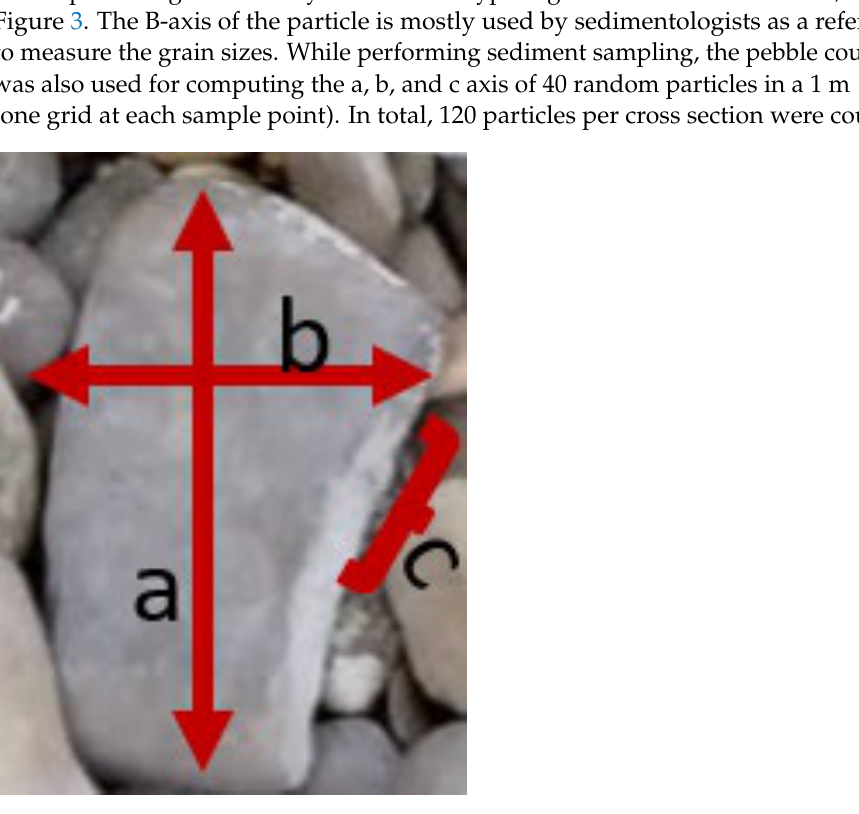
Figure 3. The typical grain measurement axis (a = long, b = intermediate, and c = short axis).